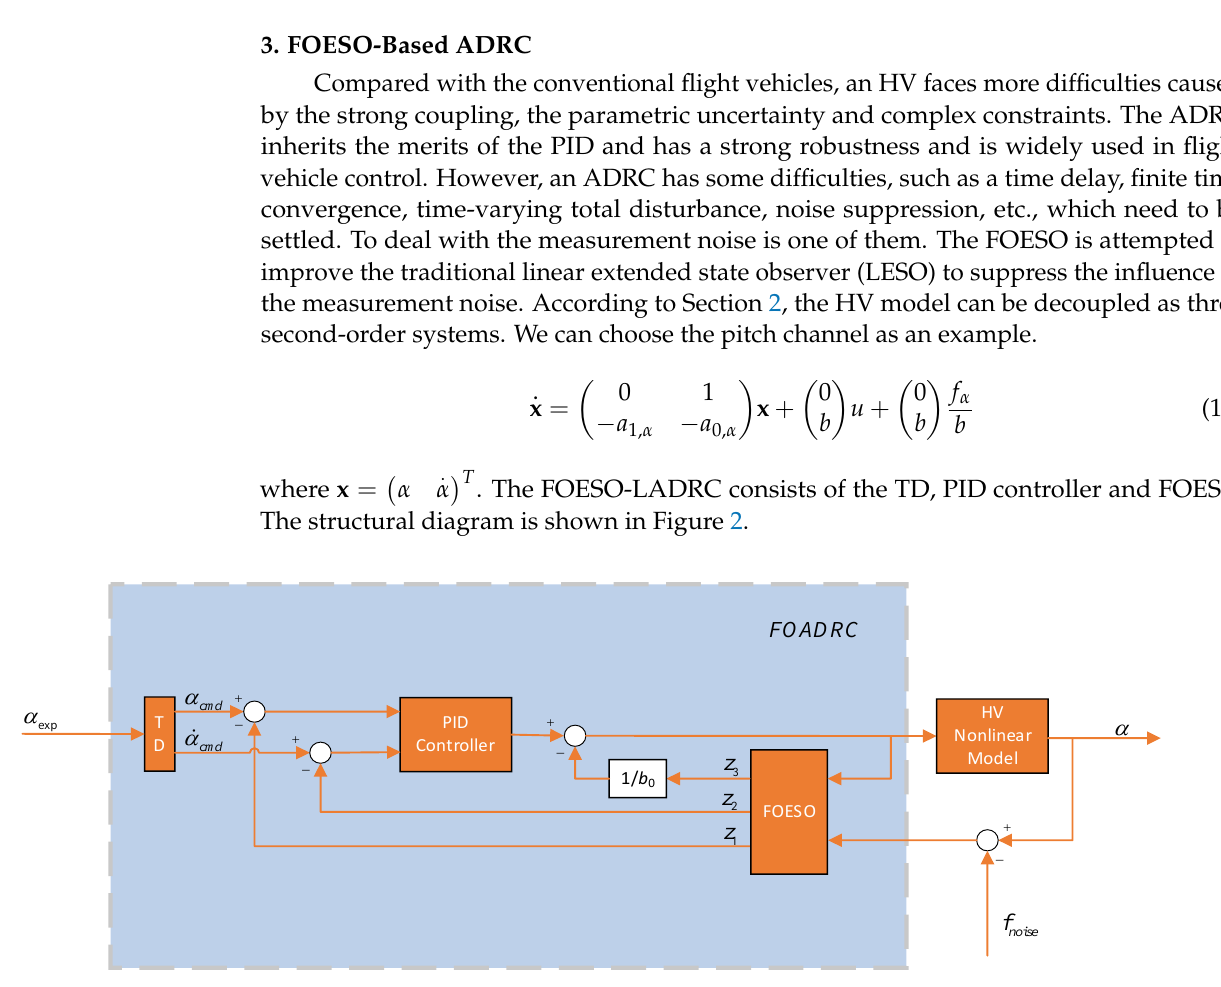
Figure 2. FOESO-based ADRC System Structure Diagram.